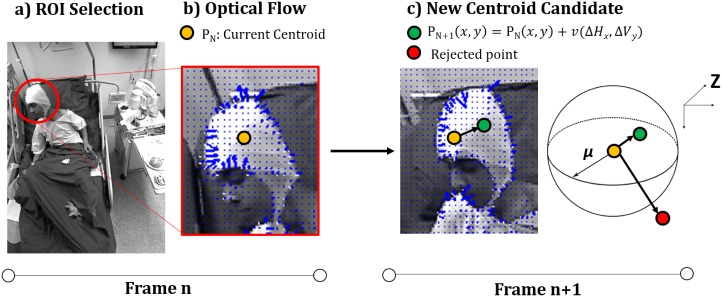
Schematic representation of the developed algorithm.The yellow and green colors are associated with the depth of the centroid in two consecutive frames. In frame n, the user selects and ellipsoid mask over the aimed ROI (Fig A). The resulting velocity vector is estimated (based on the OF pixel velocity vectors—in blue) and is used to calculate the next centroid (Fig B). In frame n + 1, the new centroid is calculated. If the depth of the estimated Pn+1(x, y) is concordant with Eq 2, the estimation is accepted (Fig C).